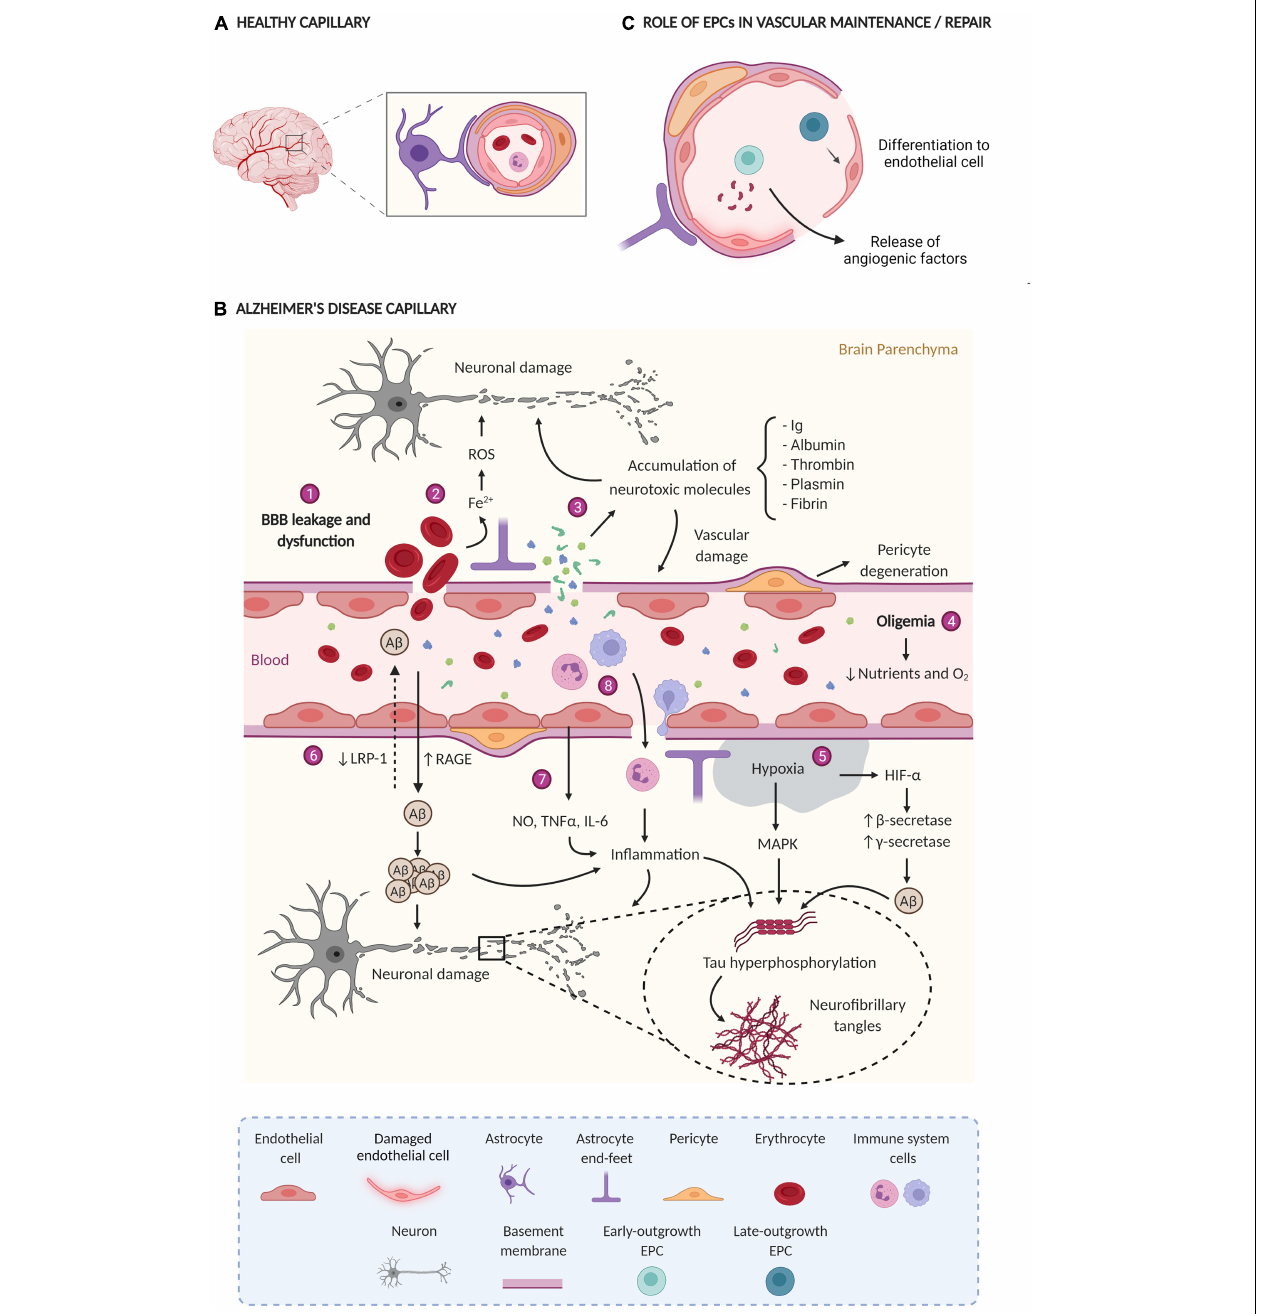
FIGURE 1 | (A) Healthy capillary; the BBB has tight junctions between endothelial cells, pericytes enveloping endothelial cells, astrocytes, and normal blood flow. (B) AD capillary; Main vascular alterations occurring in AD: (1) the rupture and dysfunction of the BBB increase the permeability of different cells and molecules; (2) the accumulation of erythrocytes in the parenchyma generates neurotoxic products (Fe 2 + ) that damage brain cells through the production of ROS; (3) the extravasation and consequent accumulation of neurotoxic molecules induces neurodegeneration and vascular damage; (4) oligemia induces a reduction in nutrient and oxygen supply, (5) generating hypoxic zones increases A β production and tau phosphorylation; (6) A β flow through the BBB is impaired due to a lower expression of LRP-1 and a higher expression of RAGE, leading to A β accumulation in the brain parenchyma; (7) blood vessels release a large amount of proinflammatory mediators (NO, TNF α , and IL-6) that together with (8) the extravasation of immune system cells generate inflammation. All together finally generate neuronal damage. ROS, reactive oxygen species; Ig, immunoglobulins; BBB, blood-brain barrier; A β , amyloid β protein; LRP-1, low-density lipoprotein receptor-related protein 1, RAGE, receptor for advanced glycation end products; NO, nitric oxide; TNF- α , tumor necrosis factor-alpha; IL-6, interleukin-6, HIF-1 α , hypoxia-induced factor 1 α ; MAPK, mitogen-activated protein kinase. (C) Role of EPCs in vascular maintenance/repair e-EPCs participate in vasculogenesis and/or angiogenesis in a paracrine manner through the release of proangiogenic factors. L-EPCs participate by directly differentiating into mature endothelial cells. Created with BioRender.com.